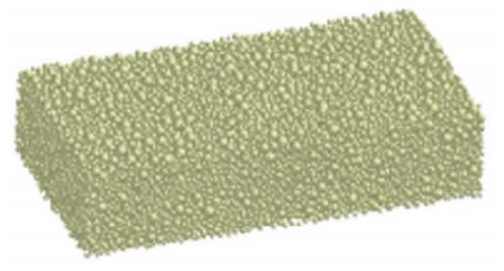
Figure 8. Soil Figure 8. Soil box.